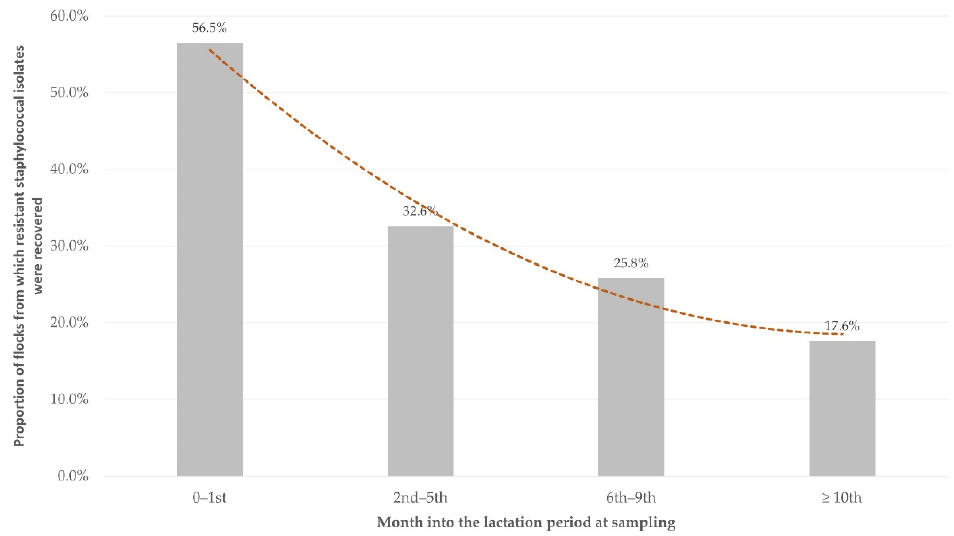
Figure 3. Proportion of flocks from which resistant staphylococcal isolates were recovered from the bulk-tank milk, in accordance with the stage of the lactation period of animals in these flocks (dashed line: trendline). Table 3. Results of multivariable analysis for isolation of resistant staphylococcal isolates from the bulk-tank milk of 325 sheep flocks in Greece.